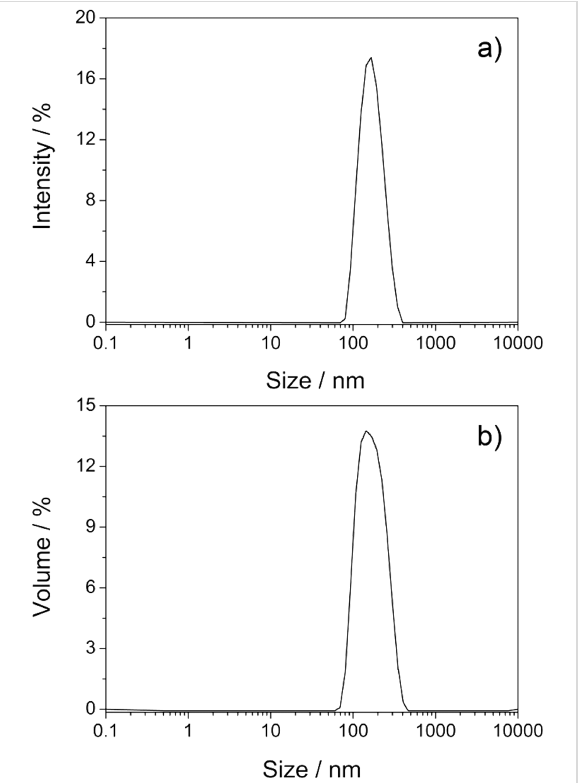
Figure 7: Size distributions of the aqueous C 60 dispersions after filtra- tion, produced by stirring C 60 in 6mM γ -CD solution in DMF/toluene (v/ v 1:1) according to procedure c ) [42]: (a) by intensity and (b) by volume.